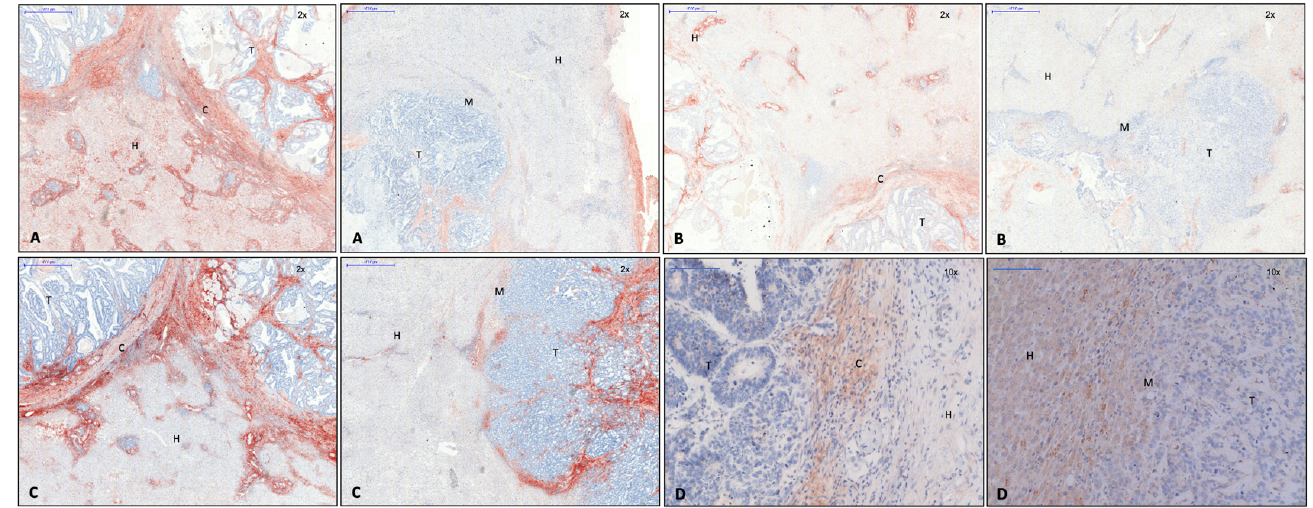
Figure 1. Left: capsule; right: no capsule. ( A ) Collagen 1 immunohistochemistry, 2× magnification. ( B ) Collagen 3 immunohistochemistry, 2× magnification. ( C ) Versican immunohistochemistry, 2× magnification. ( D ) Caldesmon immunohistochemistry, 10× magnification. Evidence of collagen 1 and 3, versican, and caldesmon in the fibrous capsule surrounding the metastasis. Legend: T, tumor; H, hepatocytes; M, tumor margin; C, capsule.